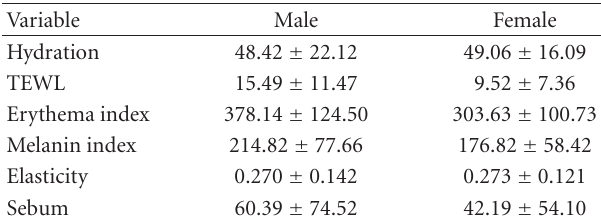
Table 1: The mean and standard deviation of skin hydration, TEWL, melanin index, erythema index, elasticity, and sebum according to